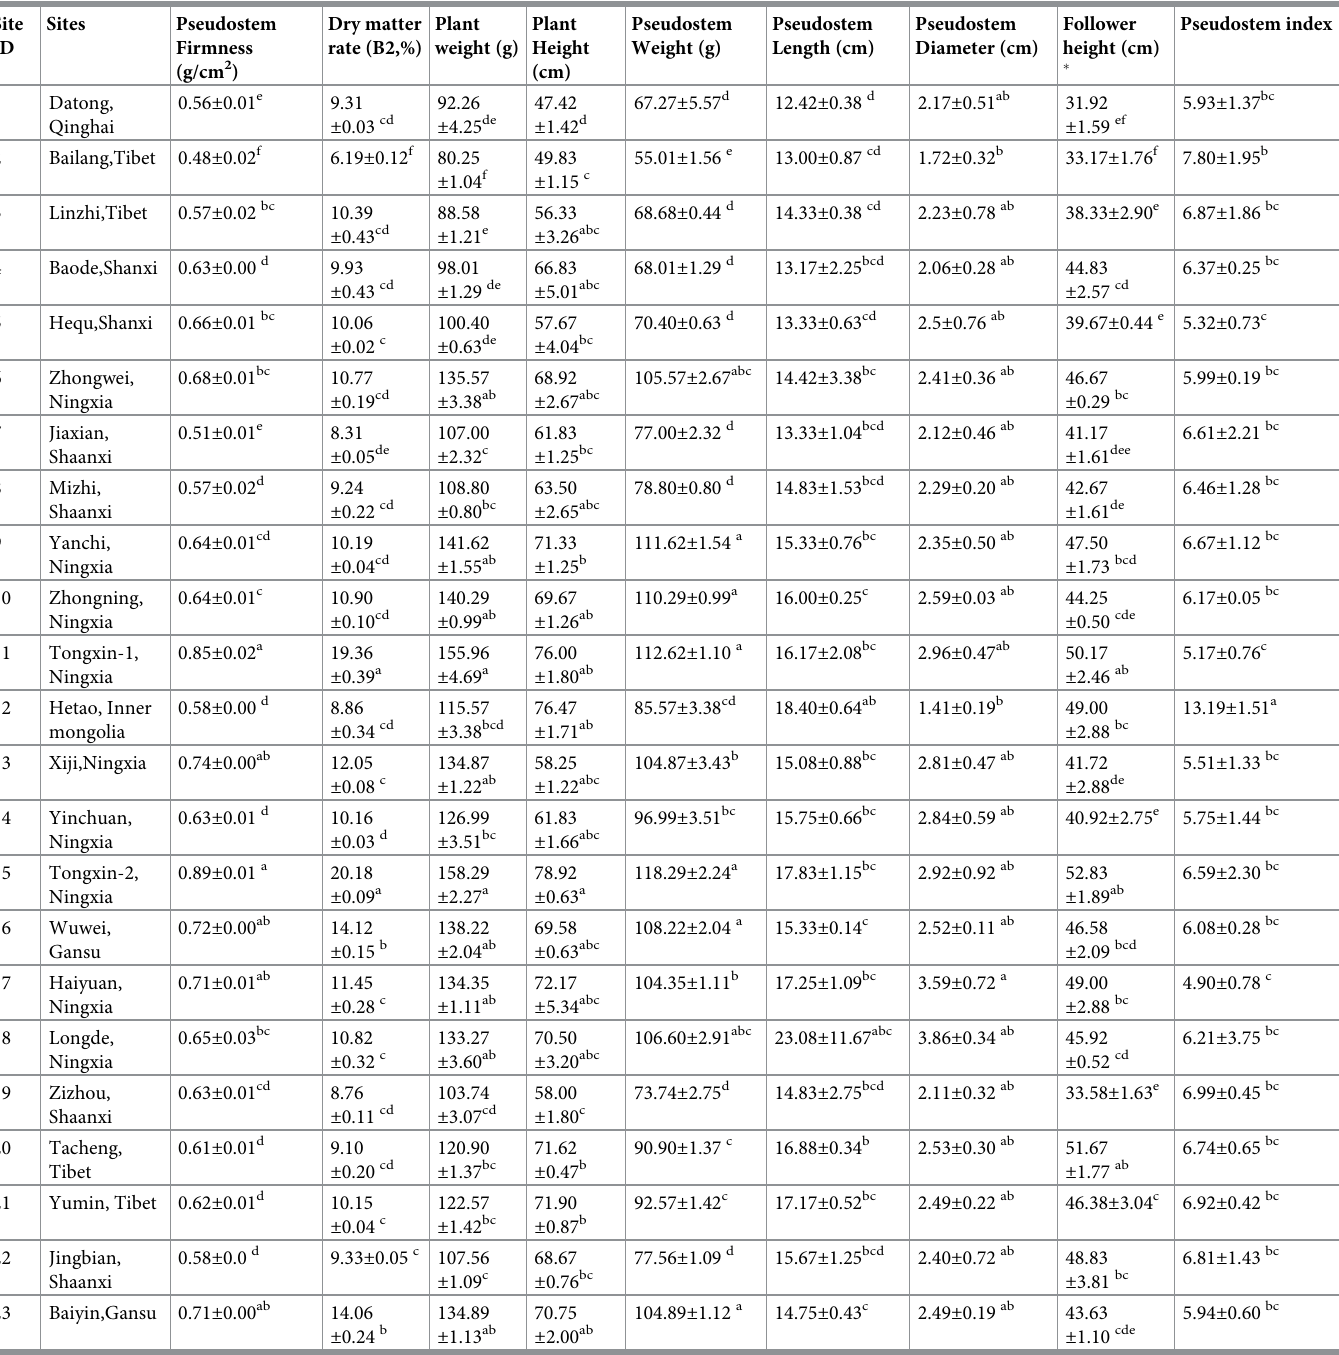
Table 1. The comparison between different biophysical traits in A . fistulosum L. var. vivip arum Makino between different sites (n =